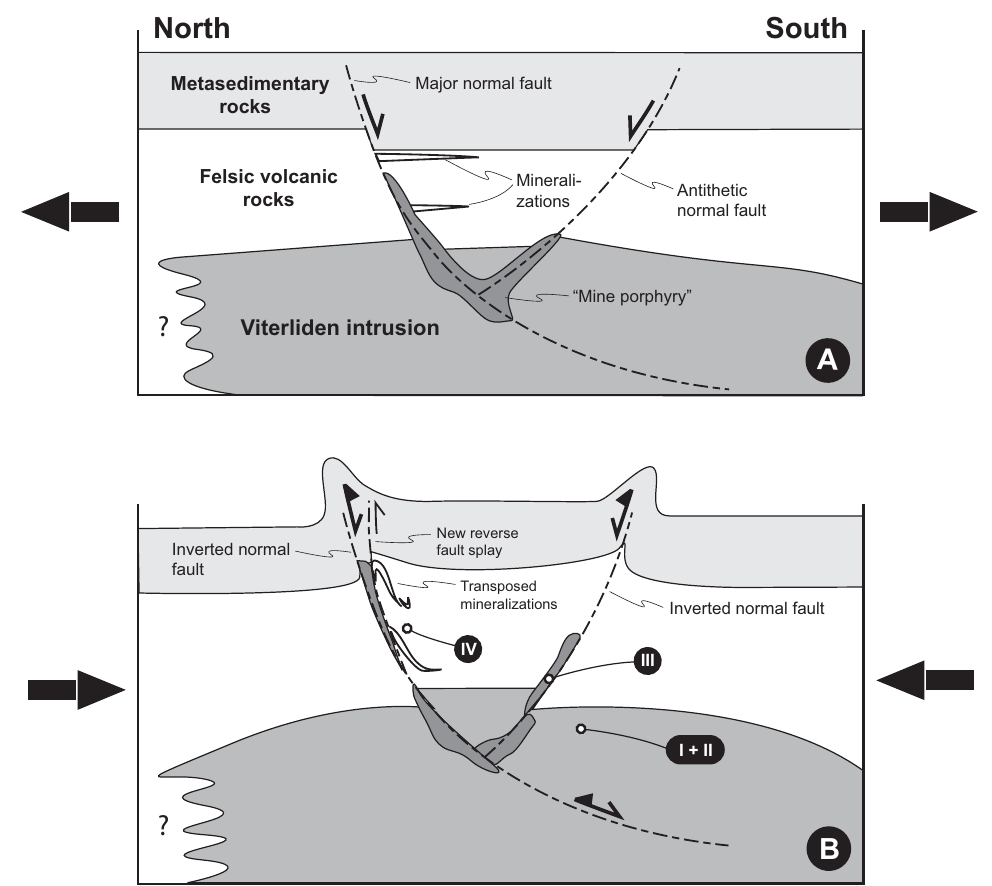
Fig. 3. Schematic stratigraphic profile across the Kristineberg area including the location of the geochronology samples. Upper mineral- ized horizon=Horntr¨ask-R¨avlidsmyran-R¨avliden, lower mineralized horizon=Kristineberg-Kimheden. Metasedimentary and metavolcanic rocks belong to the Vargfors and the Skellefte Groups, respectively. (A) Syn-extensional volcanism, mineralization sedimentation ± intrusive activity at ∼ 1.89–1.87Ga. (B) Subsequent crustal shortening leading to basin inversion and related transposition of the mineralized horizons.